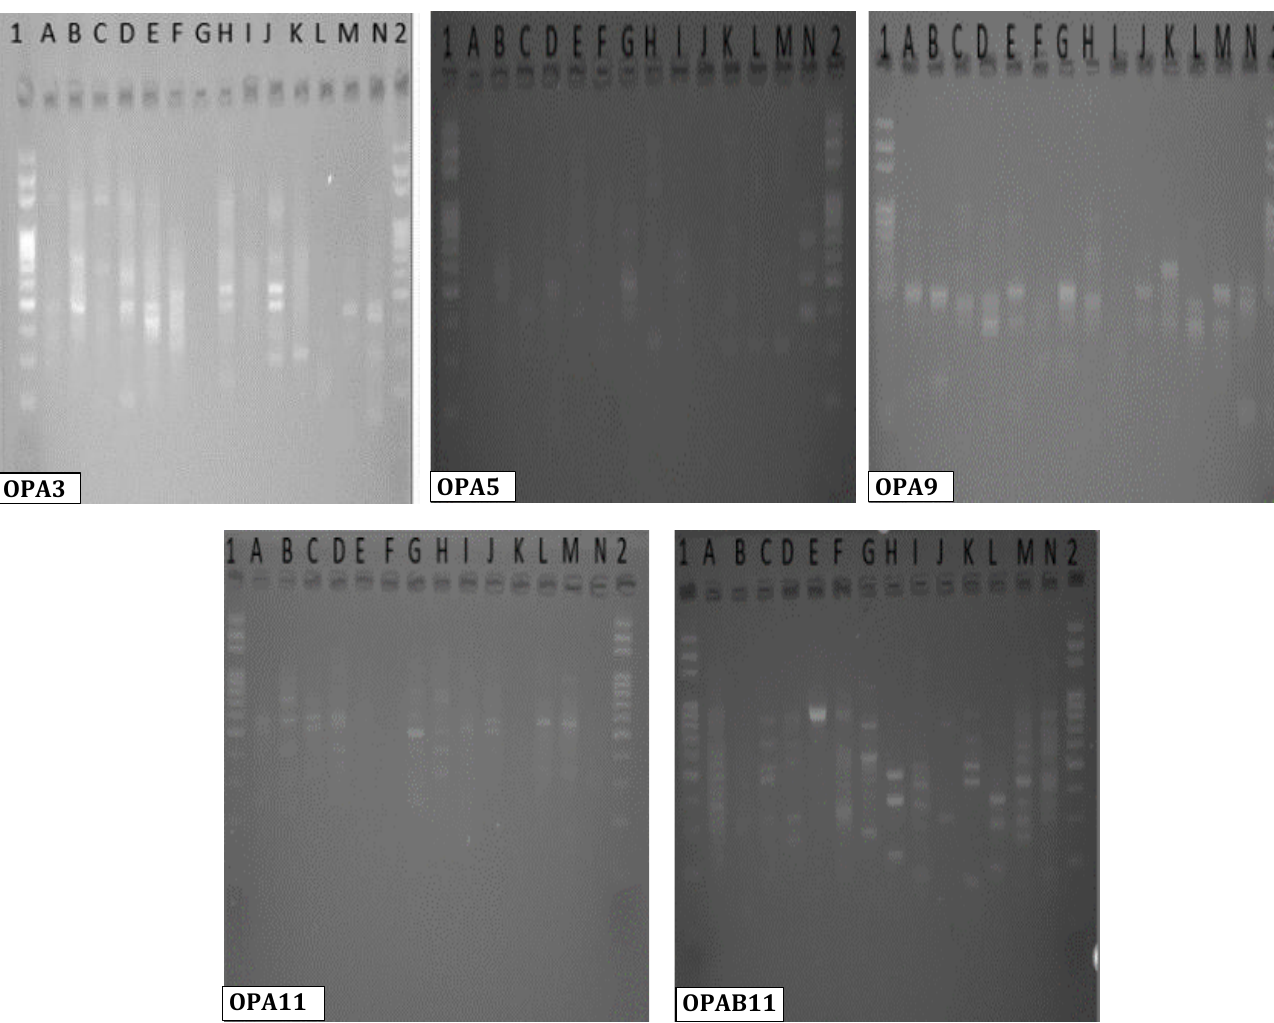
Figure 2 . The amplification patterns of some cichlid samples using RAPD OPA-03, 05, 09, 011 and OPAB 11 primers. There are several polymorphic bands ranging from 200 bp to about 2000